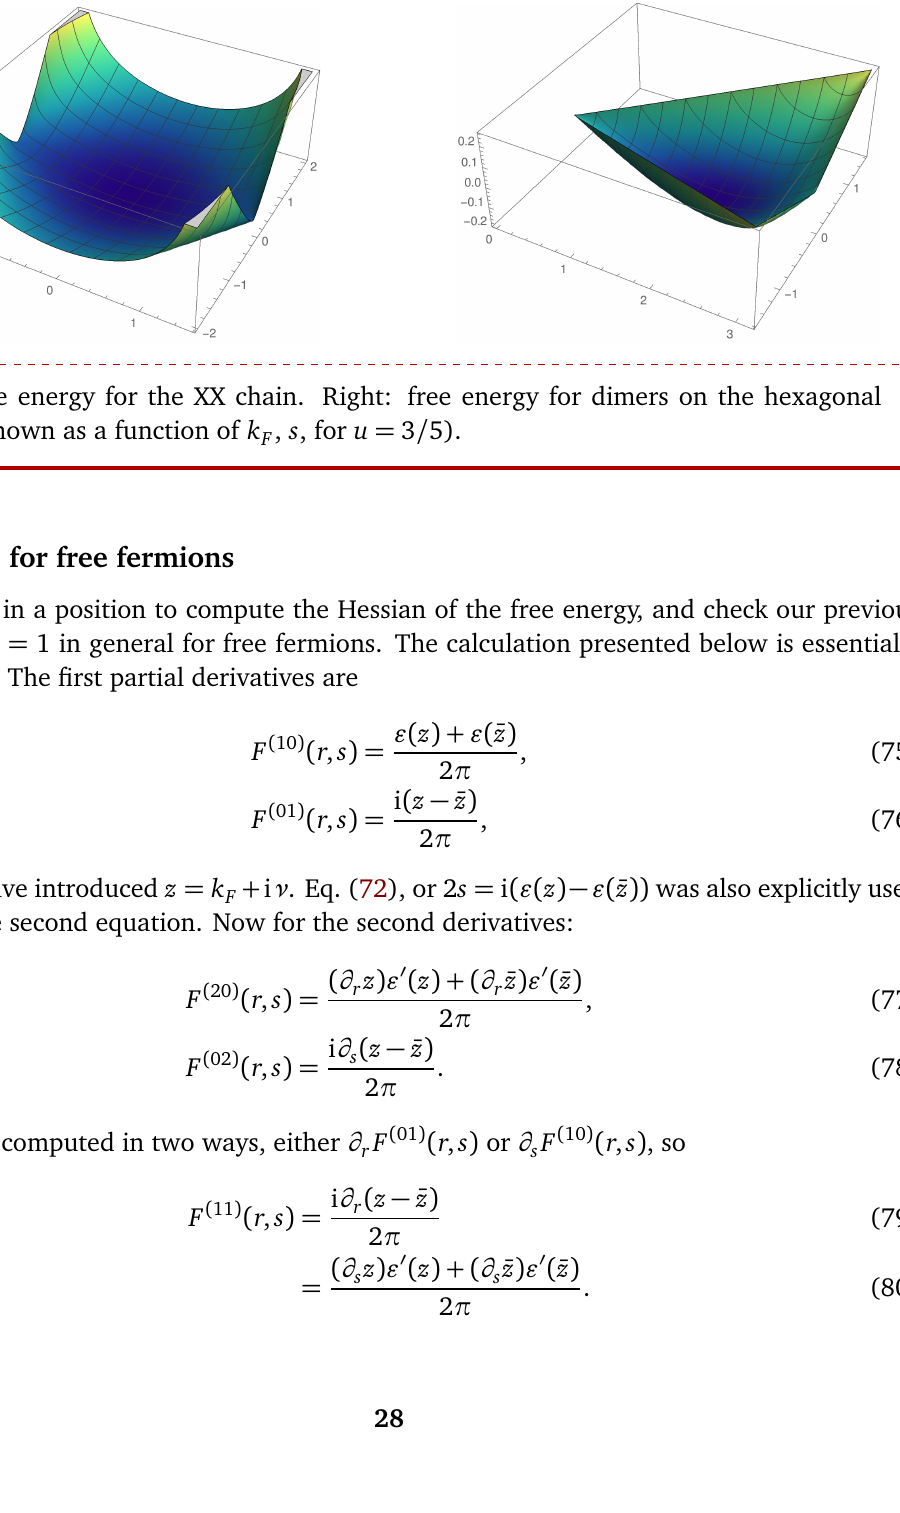
Figure 13: Examples of free energies